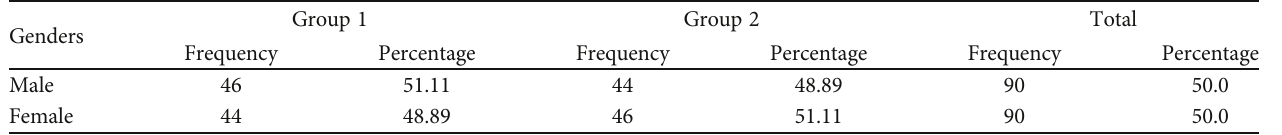
T ABLE 2: Distribution of patients according to gender in both groups.